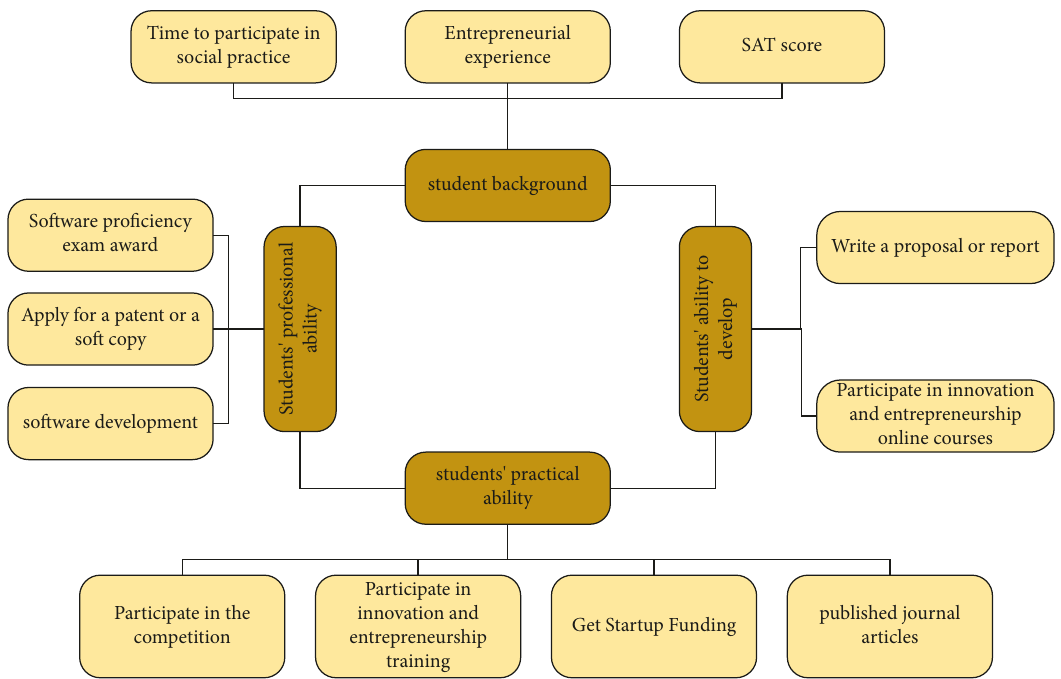
Figure 2: The main content of innovation and entrepreneurship education